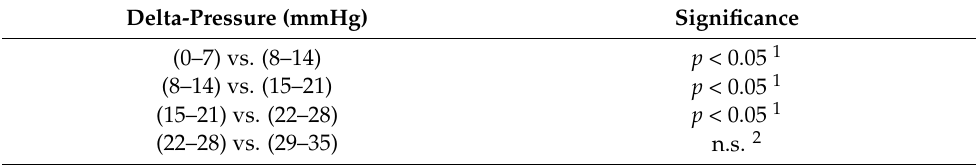
Figure 4. ( a ) Distribution of the difference between transducer intraocular pressure and Goldmann intraocular pressure (delta ‐ pressure, TIOP ‐ GIOP) for different intervals of transducer intraocular pressure, TIOP; ( b ) % frequency distribution of different intervals of delta ‐ pressure. Error bars in ( a ) are standard errors.